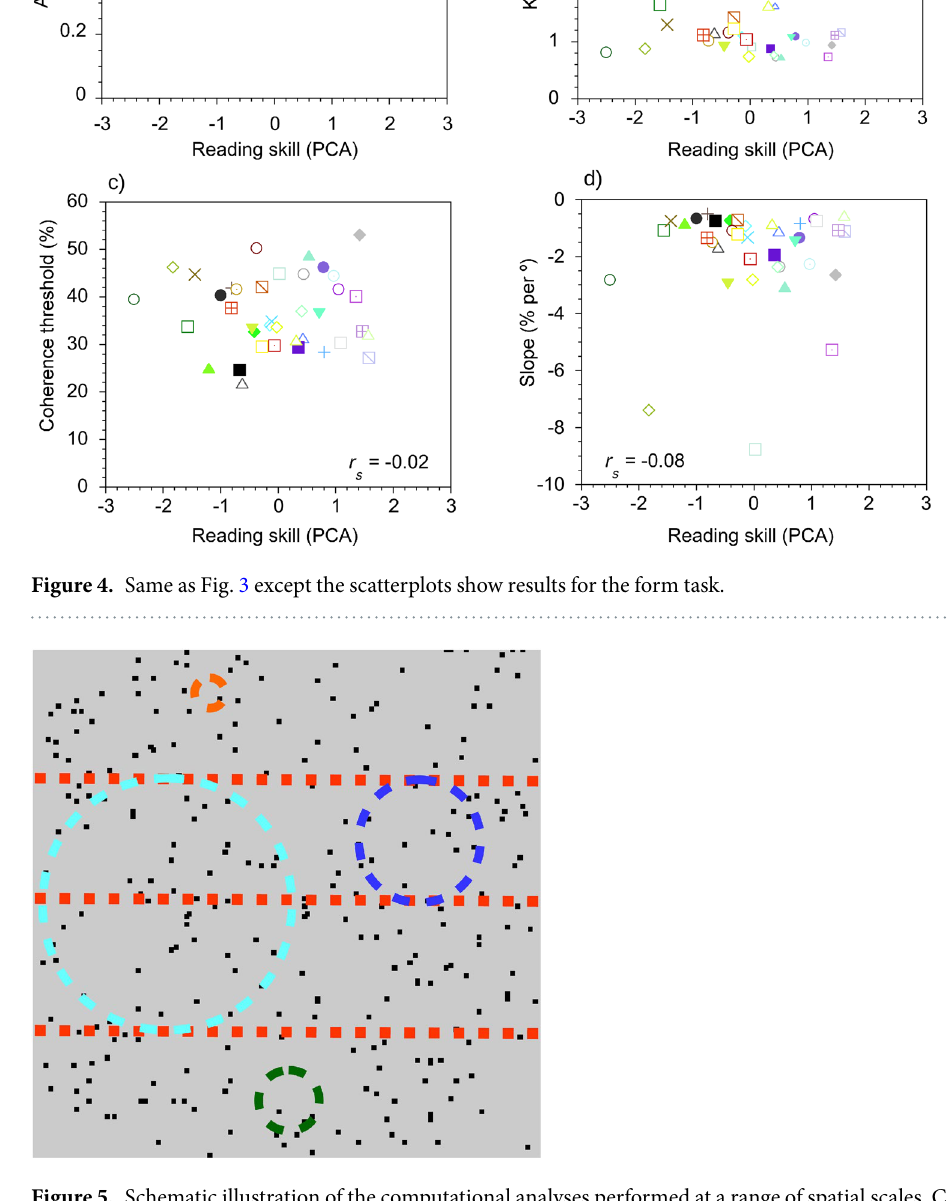
Figure 5. Schematic illustration of the computational analyses performed at a range of spatial scales. Circular integration fields of various sizes are shown superimposed upon a single frame of the spatially-segmented test stimulus, in which the dots underwent